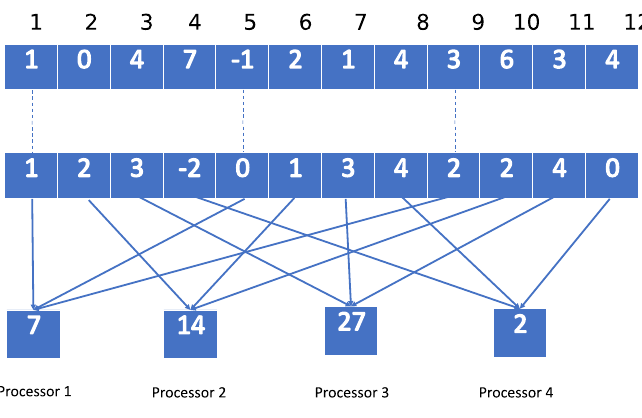
Figure 3. Illustration of an inner-product computation on the parallel platform using cyclic distribu- tion ( p = 4 and m =